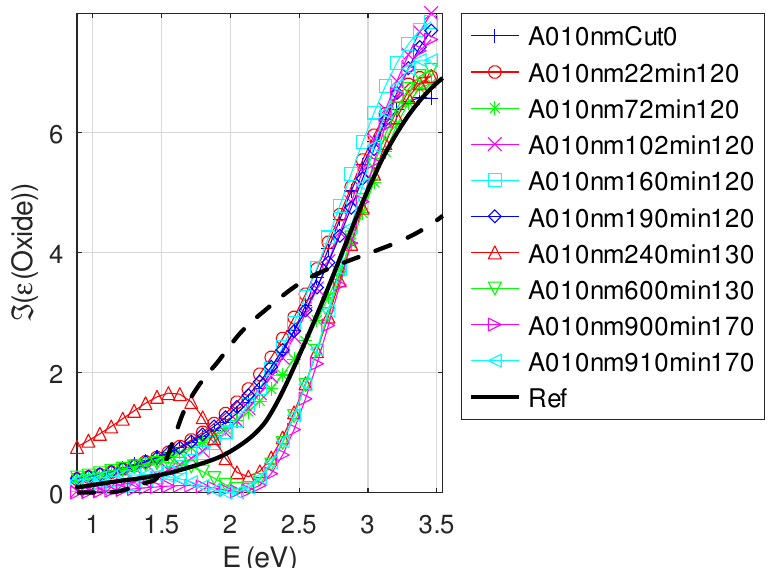
Figure A5. Imaginary part of the relative permittivity of oxide as a function of the photon energy: bulk Cu 2 O (black solid line), bulk CuO (black dashed line) and best calculated (color) for each = 10 oxidized sample (initial thickness h 0 Cu